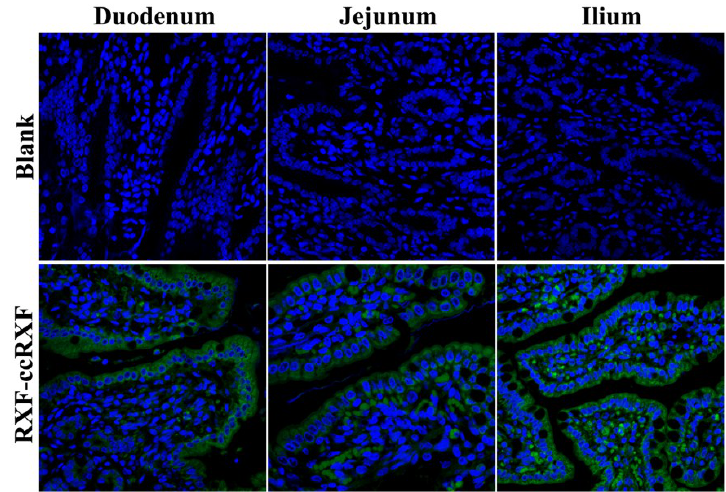
Figure 7. Ex vivo imaging of intestinal tissue sections after oral administration of CY3-labeled RXF-ccNPs inspected by CLSM. Green represents CY3-associated nanoparticles, and the cell nuclei were dyed with DAPI with 600X magnification.